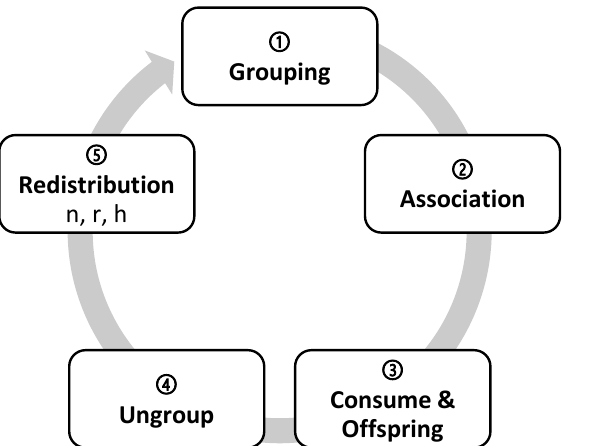
Figure 3. Transition function. Stages of the transition function. There is first a random distribution of organisms throughout the reticular network of cells, and later on, these stages are executed for each generation.